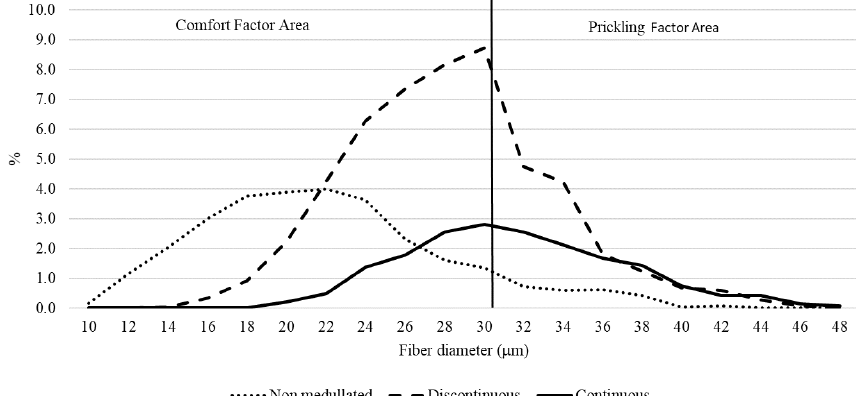
Figure 3. The distribution of each fiber category in the wool of the alpacas tested.